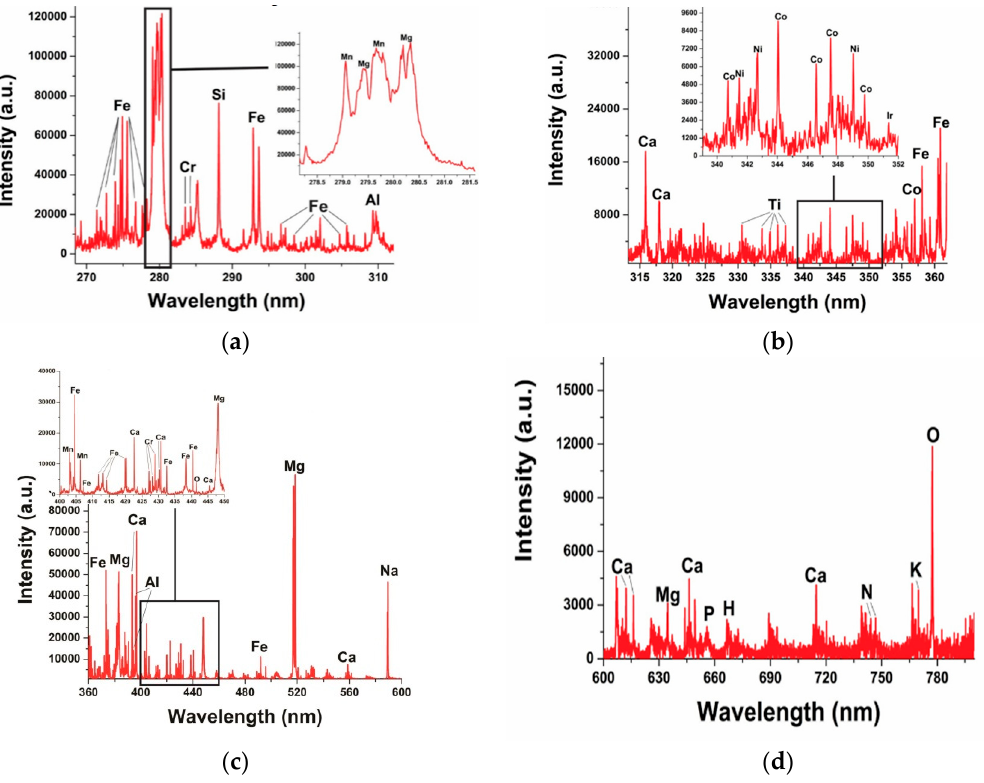
Figure 1. Typical laser-induced breakdown spectroscopy (LIBS) spectra of Dergaon meteorite in the wavelength range (a) 270–310 nm; (b) 315–360 nm; ( c ) 360–560 nm; (d) 600–800 nm.